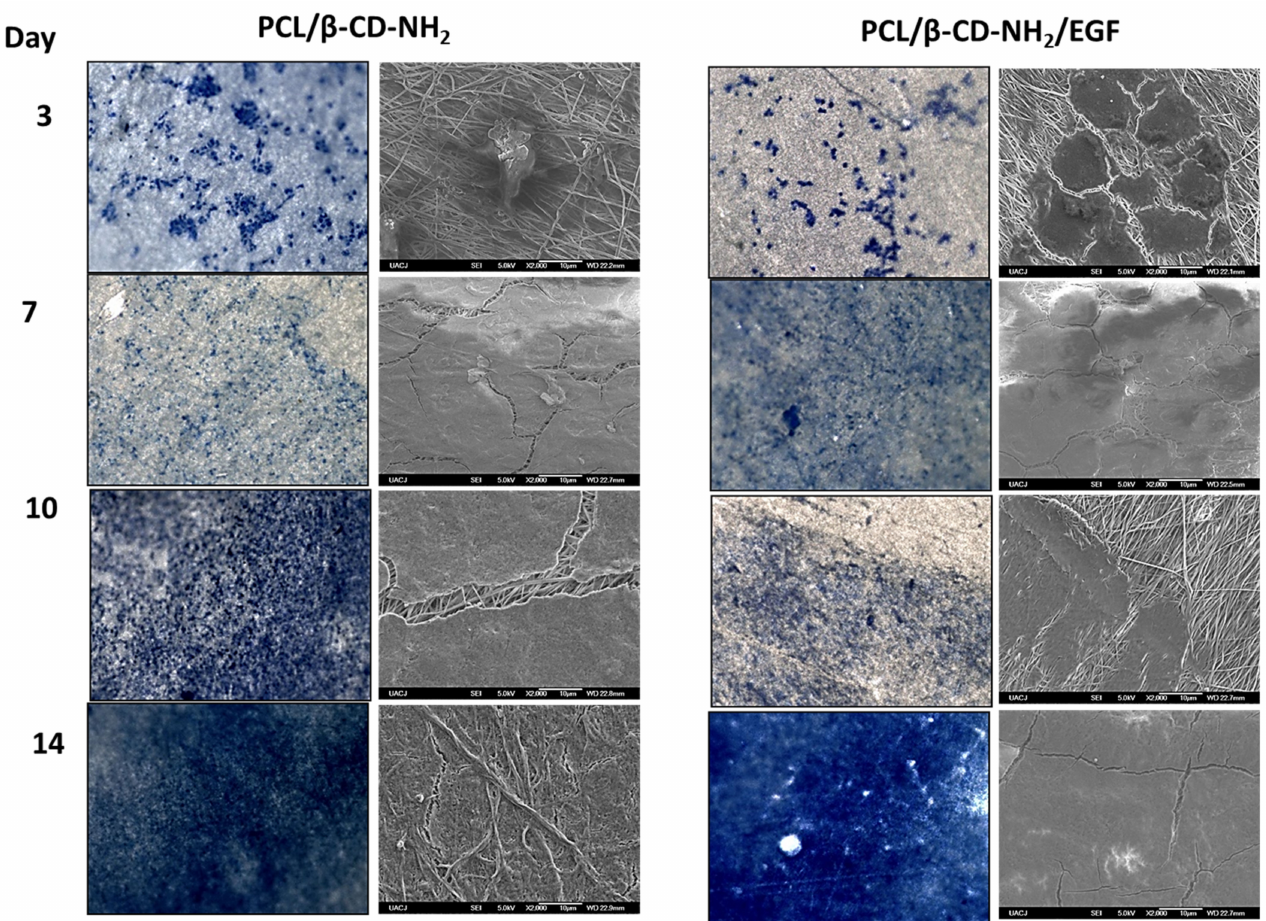
Figure 7. 3T3 mouse cells seeded on scaffolds (aminated nanofibers and aminated nanofibers with EGF) analyzed on days 3, 7, 10, and 14; Methylene blue staining cells, images 40 × (colored images on left). Scanning electron microscopy (SEM) micrographs 2000 × (gray images to the